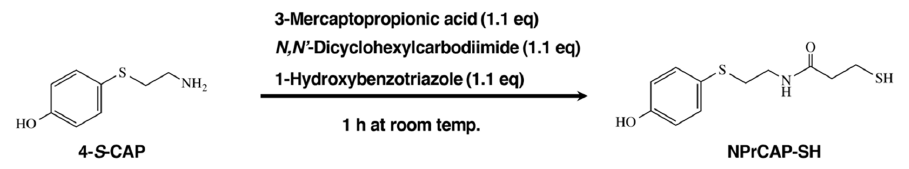
Figure 4. One-pot synthesis of NPrCAP-SH.